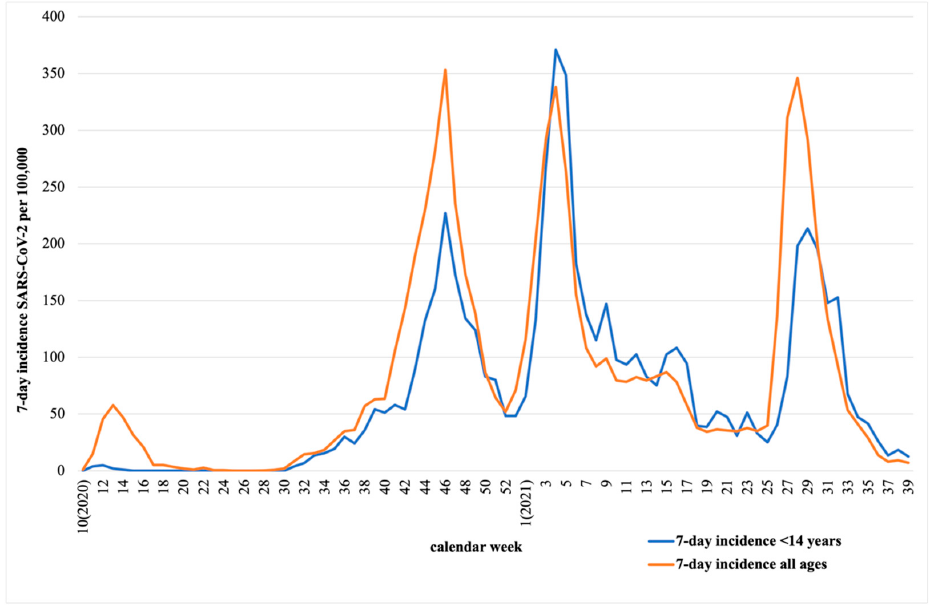
Figure 1. Comparison of 7-day-incidence SARS-CoV-2 per 100,000 inhabitants of the total population vs. 7-day-incidence per 100,000 inhabitants under 14 years of age in Asturias from March 2020 to September 2021.